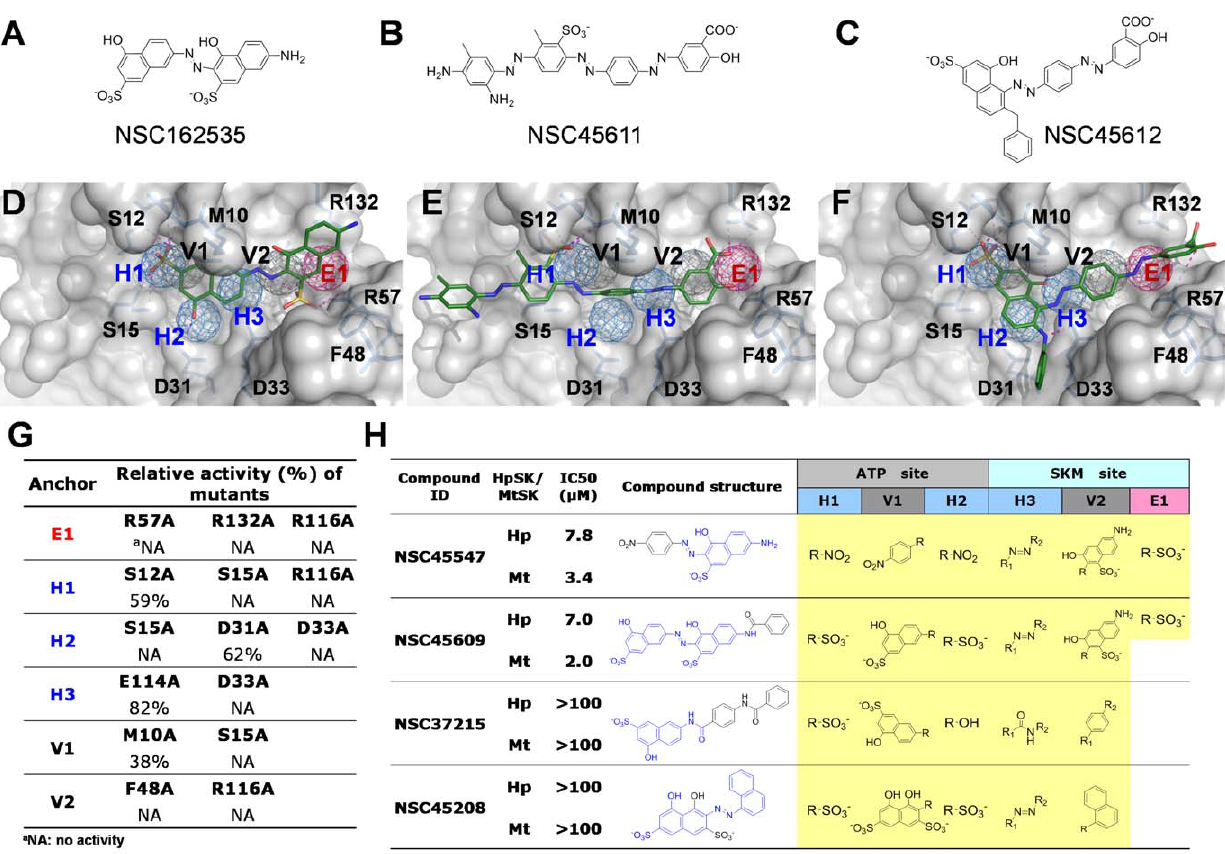
Figure 6. Characterization of shikimate kinase inhibitors by enzyme assay, CoreSiMMaps, site-mutagenesis studies, and analogues. (A–C) Structures of three inhibitors, NSC162535 ( 2 ), NSC45611 ( 1 ), and NSC45612 ( 3 ). (D–F) Relationships between anchors and docked mode of each inhibitor for HpSK. These compounds consistently include two negative charge moieties (SO 3 2 or CO 2 2 ) that form hydrogen bonds with conserved interacting residues of anchors E1 and H1. (G) Comparison of relative activities of HpSK mutants. The conserved interacting residues for each anchor were mutated. R57, R132, R116, and F48 located in the shikimate site were critical for the enzymatic functions. (H) Potency of NSC162535 analogues. The substitution moieties of analogues are indicated in black. Those that lack the E1 moiety greatly lost the inhibitory effects (IC 50 . 100 m